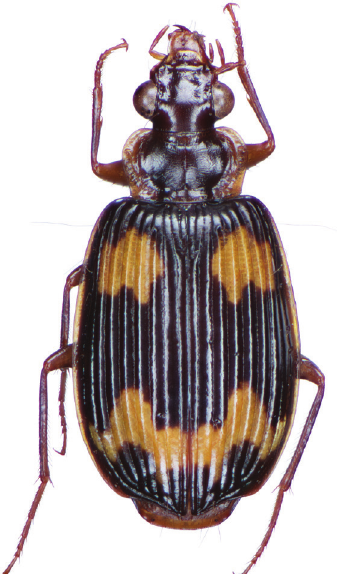
Figure 44. Dorsal habitus and color pattern of C. ( Coptoderina ) maculata (Dupuis) . (OBL 6.66 mm). Macrosculpture . Dorsum of head and clypeus faintly rugulose to smooth, with rela- tively dense, fine and scattered setigerous punctures, setae hardly visible at 50×; pro- notum with fine and scattered setigerous punctures, visible in side view at 50×, disc shallowly regulose; elytra with intervals broadly rounded, single row of fine setigerous punctures in the center of each interval, these punctures larger than additional scattered setigerous puncture throughout disc, striae with single row of fine setigerous punctures hardly visible in lateral view at 50×; ventrally, thoracic and abdominal sclerites with scat- tered setigerous punctures